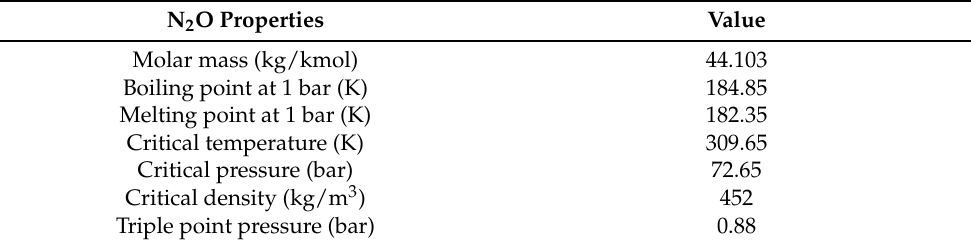
Table 1. Nitrous oxide properties